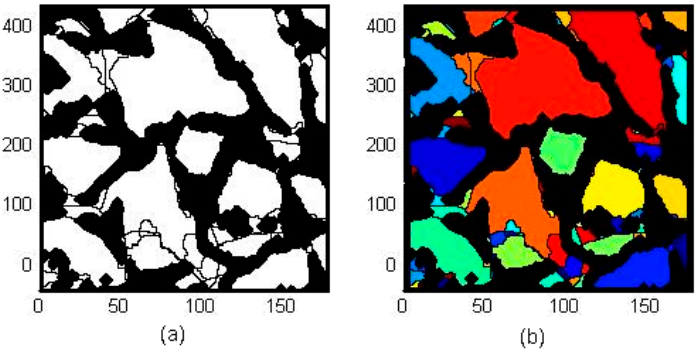
Figure 12. ( a ) Final segmentation result; ( b ) colorized image for better detail.